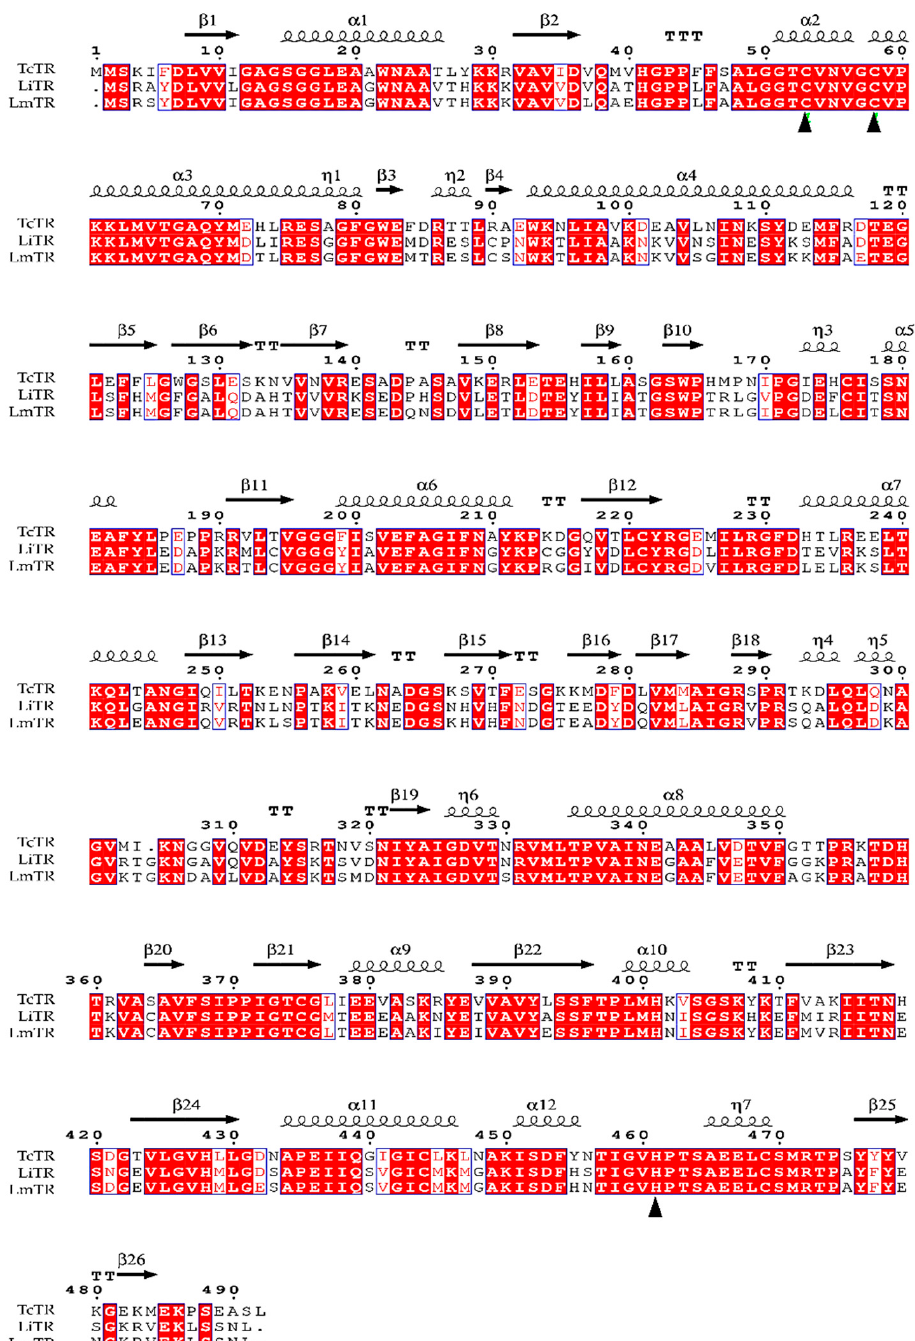
Figure 1. Multiple sequence alignment of trypanotione reductase from L. infantum , L. mexicana , and Trypanosoma cruzi . The LmTR sequence (XP_003871925.1) was aligned with homologous TR from T. cruzi (CAA78360.1) and L. infantum (XP_001462998.1) with a crystallographic structure reported in the PDB. Identical (conserved) amino acids in di ff erent sequences are marked with red-filled boxes, and the catalytic site (Cys52, Cys57, and His461) is shown with a triangle ( (cid:78) ). The alignment was performed in the Clustal-W program and ENDscript